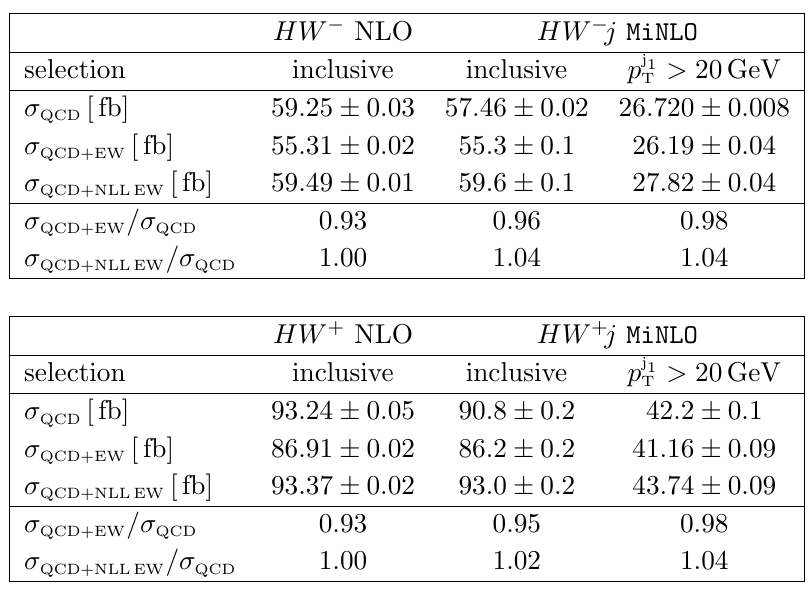
Table 1. NLO total cross sections for HV (second column) and HVj (third and fourth column) production with V = W (cid:0) (top) and V = W + (bottom), at a center-of-mass energy of p s = 13 TeV, at NLO QCD, NLO QCD+EW, and in the NLO QCD+NLL EW approximation. The HVj cross sections are based on the improved MiNLO procedure (third and fourth column). The e(cid:11)ect of a cut of p j1 > 20 GeV on the transverse momentum of the hardest jet in HVj production is shown in the T last column. Listed uncertainties are due to Monte Carlo integration.